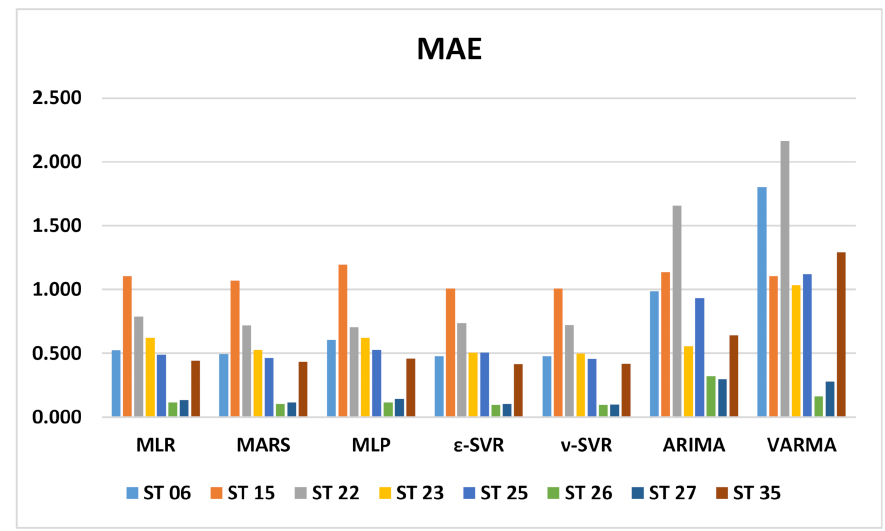
Figure 3. MAE error for all models and stations.